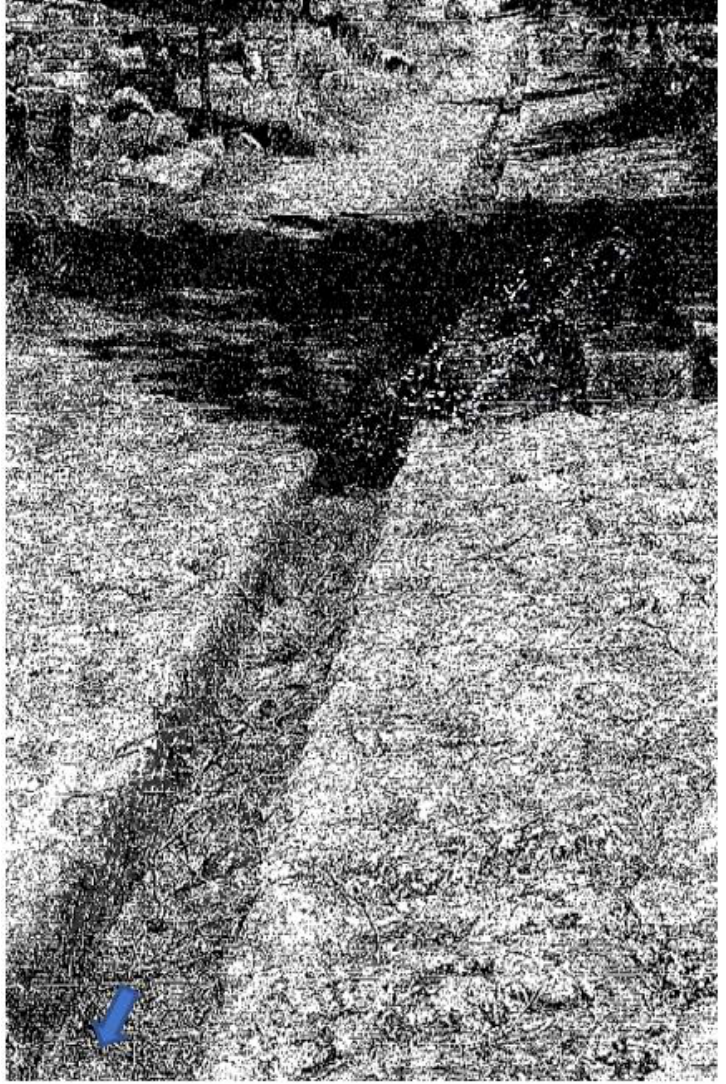
Figure 14. Steep channel along the center of the Priene main east–west throughfare, leading water drainage from housing and the agora to the complex West Gate drainage structure shown in Figure 15. Approximate mean channel width ~1.2 m; approximate mean channel depth ~0.25 m. Arrow denotes flow direction. Photo by author at Priene in Turkey.